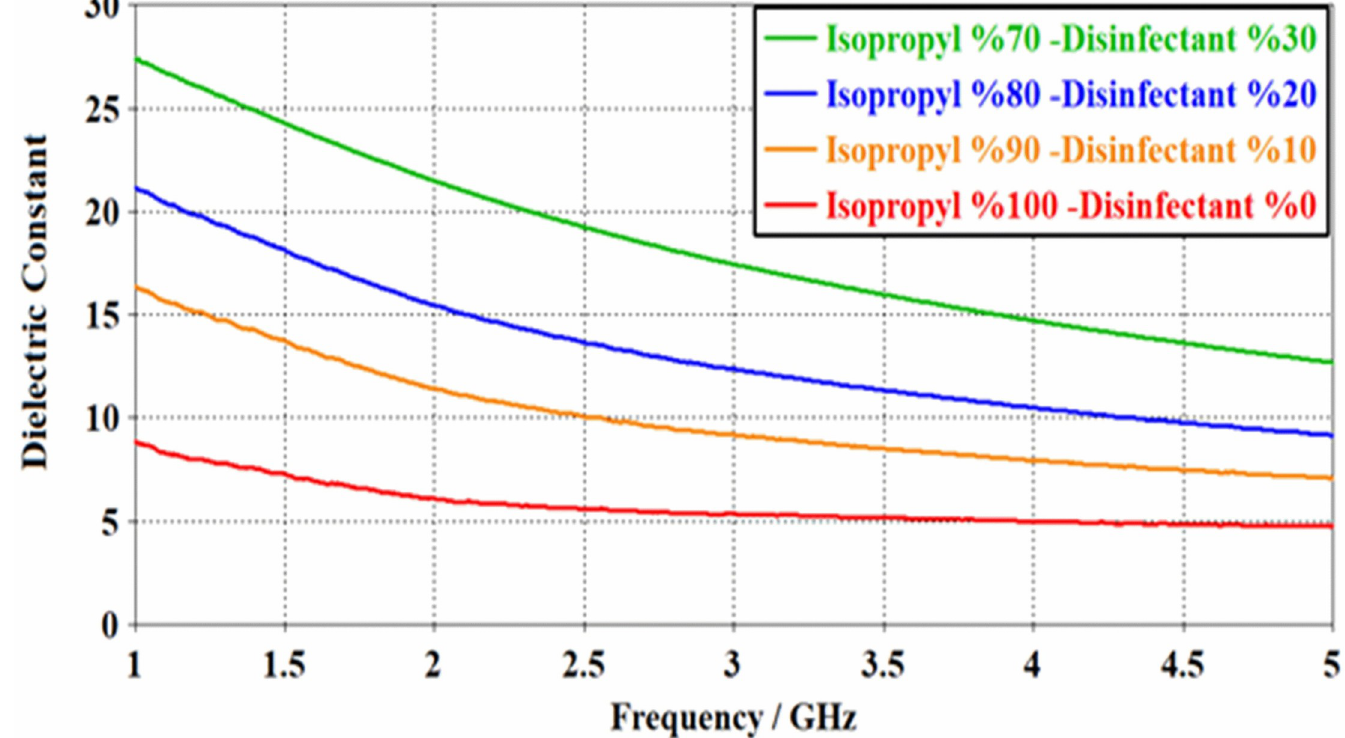
Fig 4. Dielectric values for disinfectant-isopropyl in the frequency range from 1 to 5 GHz.